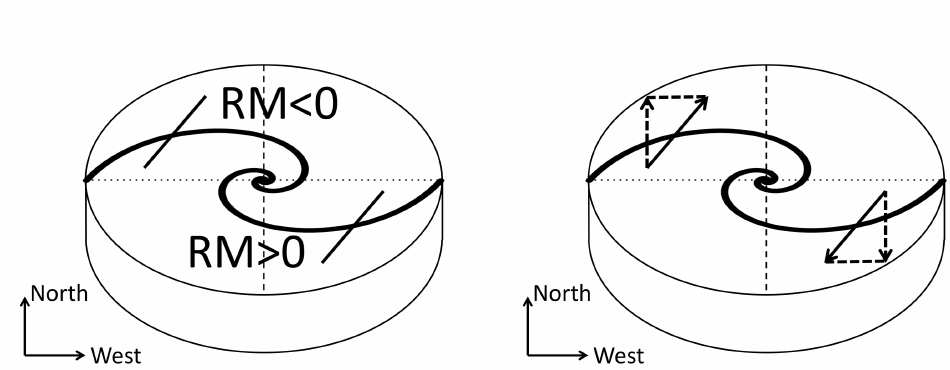
Figure 3. Determination of direction of magnetic-field vector based on a sign of the